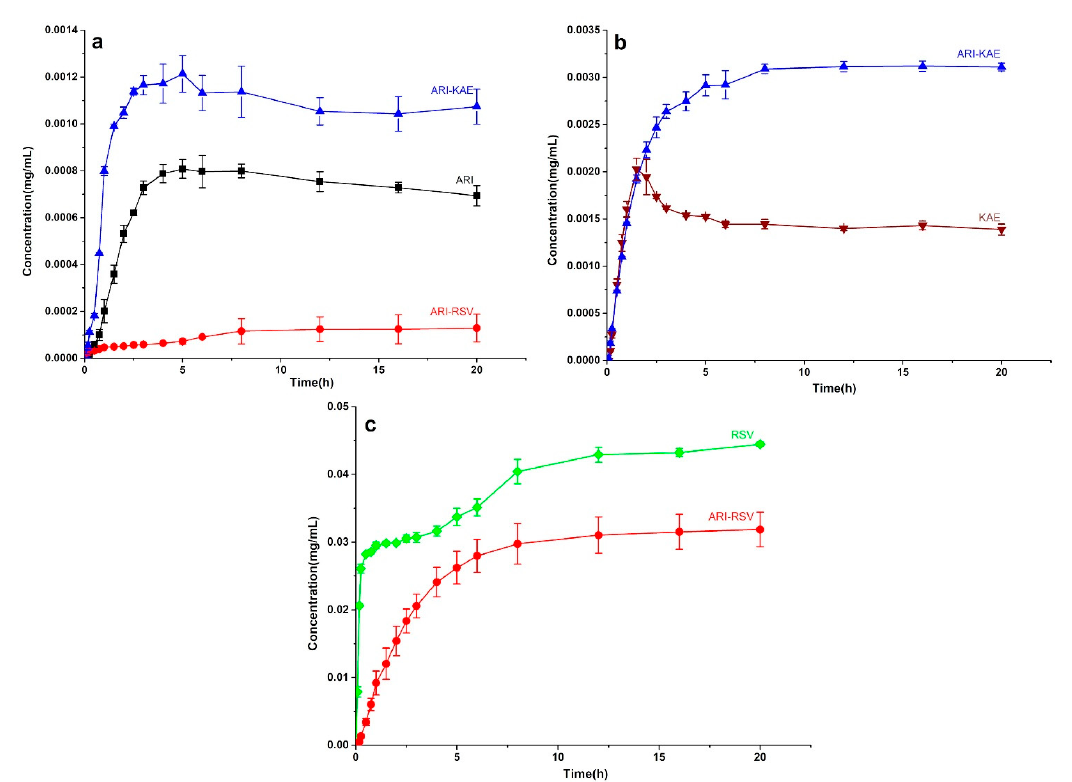
Figure 12. The dissolution profile of ARI-KAE and ARI-RSV at pH = 6.8 phosphate buffer, ( a ) ARI from pure ARI, ARI-RSV, and ARI-KAE, ( b ) KAE from pure KAE and ARI-KAE, ( c ) RSV from pure RSV and ARI-RSV.